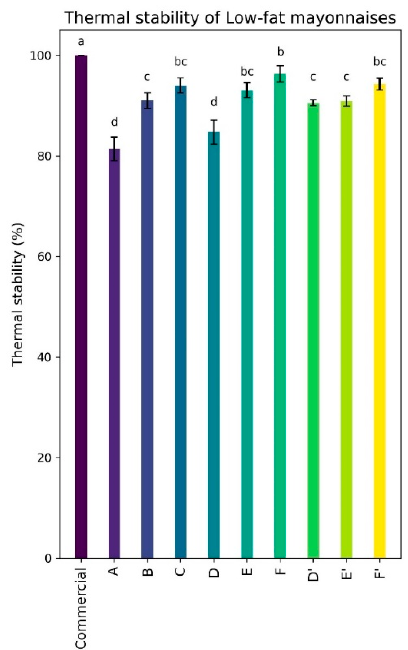
Figure 1. Thermal stability of low-fat mayonnaises. A, B, C = sodium alginate low fat mayonnaises with 30, 22.5 and 15% oil. D, E, F = low fat mayonnaises with 30, 22.5 and 15% oil and soy protein isolate. D’, E’, F’ = low fat mayonnaises with 30, 22.5% oil and spirulina protein concentrate. Different superscript letters indicate significant difference ( α = 0.05).